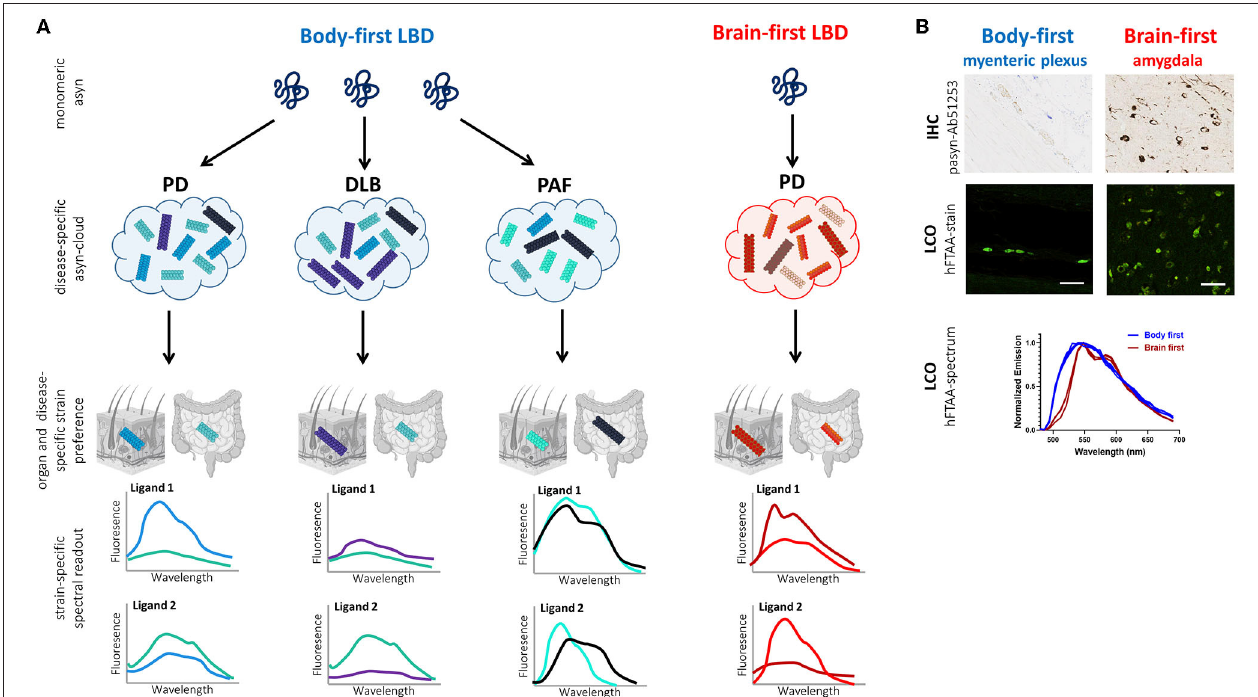
FIGURE 4 | Working principle of LCO-mediated asyn-strain characterization in LBDs. (A) The strain hypothesis applied to body-first and brain-first LBDs: monomeric asyn may misfold into any pathogenic conformer (influenced by the cellular milieu at the disease onset site), which is responsible for determining which LBD-subtype a patient develops: typical body-first PD (with pre-motor iRBD), DLB, PAF, or brain-first PD (without pre-motor RBD). Due to bidirectional trans-synaptic spread, we hypothesize that each LBD is characterized by a subtype-specific mix of oligomeric and protofibrillar species, the subtype-specific “asyn cloud”, responsible for its phenotype. Furthermore, the cellular environment in a certain organ may favor one conformer over the other from a patients’ asyn cloud. Consequently, the spectral fingerprint of pathology in peripheral biopsies likely differs across organs (such as skin and gut) and LBD-subtypes. A combination of multiple fluorescent LCO-ligands on gut and skin biopsies may enable more accurate stratification in pre-motor disease stages, limiting late and misdiagnosis, paving the way for more accurate prognosis and personalized treatment. Furthermore, we speculate that DLB-subtypes may have a more similar cloud distribution, compared to MSA, since asyn in MSA is mainly confined to oligodendrocytes and not neurons/axons. (B) Histology and LCO data in the gut (myenteric plexus) and amygdala of a gut- and brain-first wild-type rodent model, respectively. Immunohistochemistry (IHC) against phosphorylated asyn (Ab51253) is unable to differentiate between gut and brain pathology. In contrast, the LCO assay using the hFTAA-ligand shows a clear difference in the spectrum of gut- and brain-derived aggregates with a more typical two-peak hFTAA spectrum in the brain, indicating gut and brain pathology possess different structural characteristics despite using the same seeds for disease initiation (preliminary data). Scalebar: 50 µ m